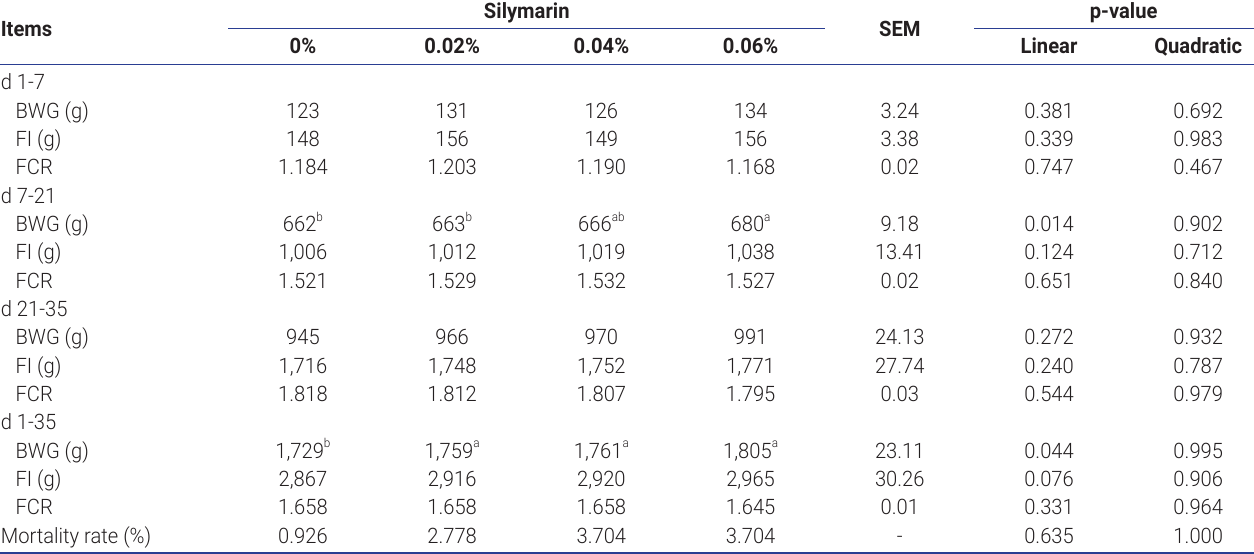
Table 2. The effect of Silymarin supplementation on growth performance of broiler Items